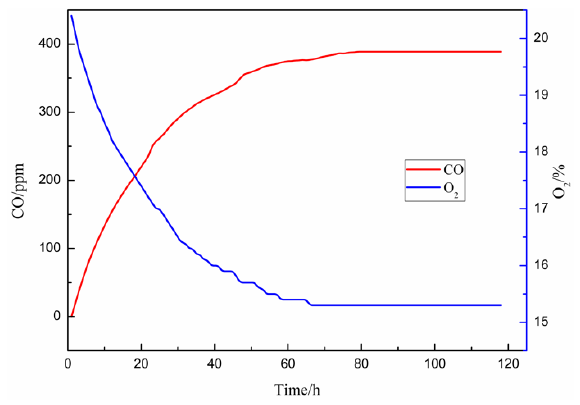
Figure 2. Curves of the first time of ambient temperature oxidation experiment results.